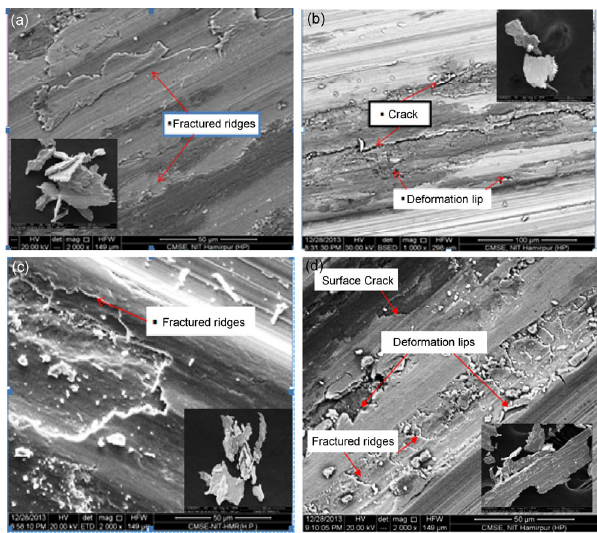
Fig. 9 FESEM micrograph photos of the worn surfaces generated under the wear test at a normal load of 140 N and sliding velocity of 1.885 m/s for different treatments: (a) A3T, (b) ATC1(6)T, (c) ATC1(21)T, and (d) ATC1(36)T. Insets represent the wear debris generated in the respective sample.